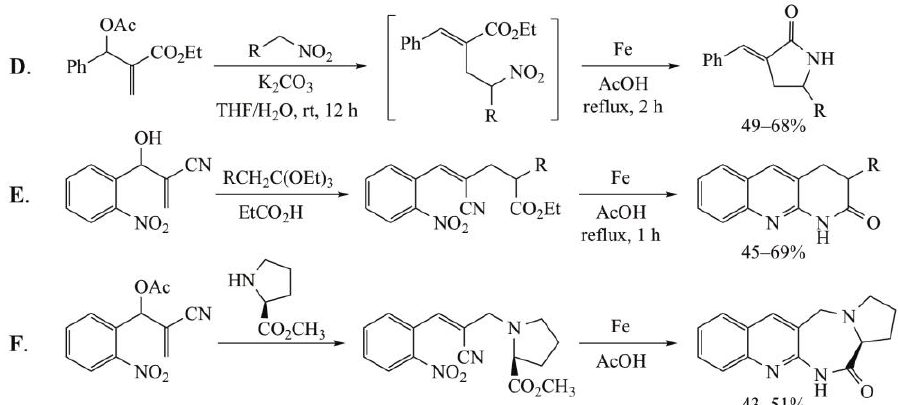
Figure 1. Some previous nitrogen heterocycle syntheses from MBH precursors. ( A ) Formation of quinolines; ( B ) formation of N -substituted-1,2-dihydrobenzo[ b ][1,8]-naphthyridines; ( C ) formation of dihydroacridines; ( D ) formation of γ-lactams; ( E ) formation of 3,4-dihydrobenzo[ b ][1,8]naphthyridin-2(1 H )-ones; ( F ) formation of fused polycyclic quinolines.